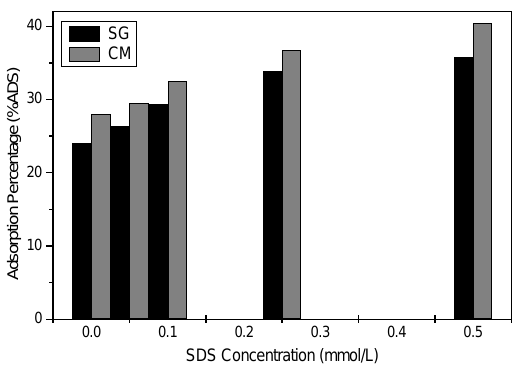
Figure 9. Effect of the presence of detergent Sodium dodecyl sulphonate (SDS) on the adsorption of phenol onto Sargassum sp. (SG) and Chaetomorpha (CM) . Phenol concentration 100 mg/L; Initial solution pH: 10; masses of SG and CM: 40 mg and 100 mg, respectively.